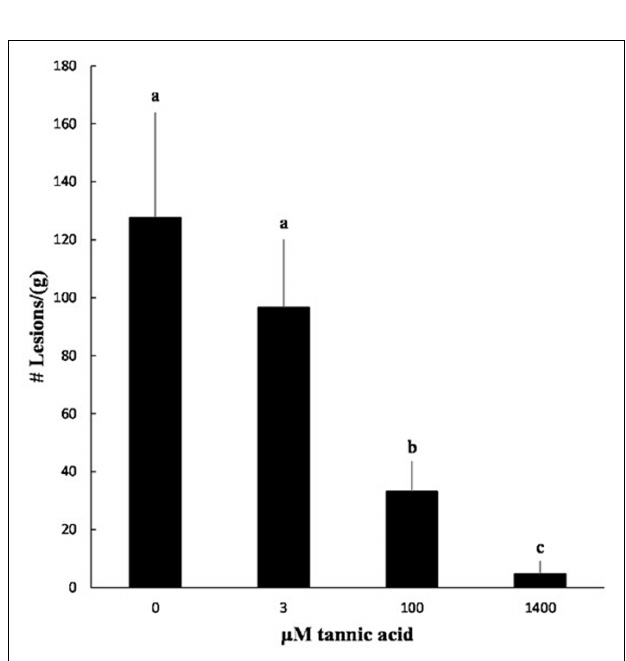
FIGURE 7 | Effect of tannic acid on symptom formation by X. fragariae Fa P29. Shown is the average number of lesions per gram of strawberry leaf tissue from three independent experiments measured 14 days after foliar inoculation with X. fragariae Fa P29 and increasing concentrations of tannic acid. Statistical significance was determined by a t -test assuming unequal variance; p -values less than or equal to 0.05 were considered significant. Bars with the same letter represent averages that were not significantly different from each other. Error bars denote standard